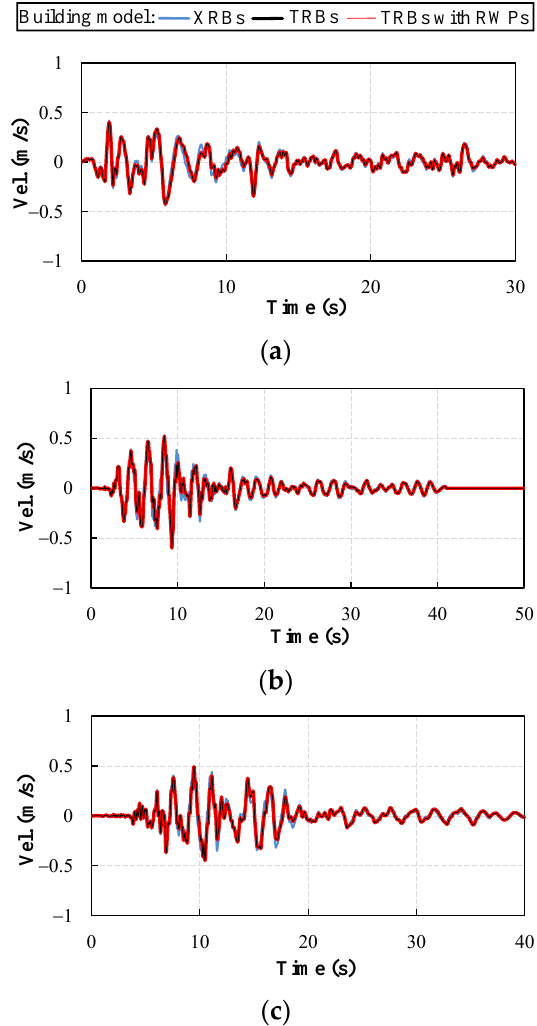
Figure 8. Velocities of the 1st floor under the ground motions at a 2 – 3% PE in 50 years: ( a ) El Centro; ( b ) Kobe; ( c ) Northridge.